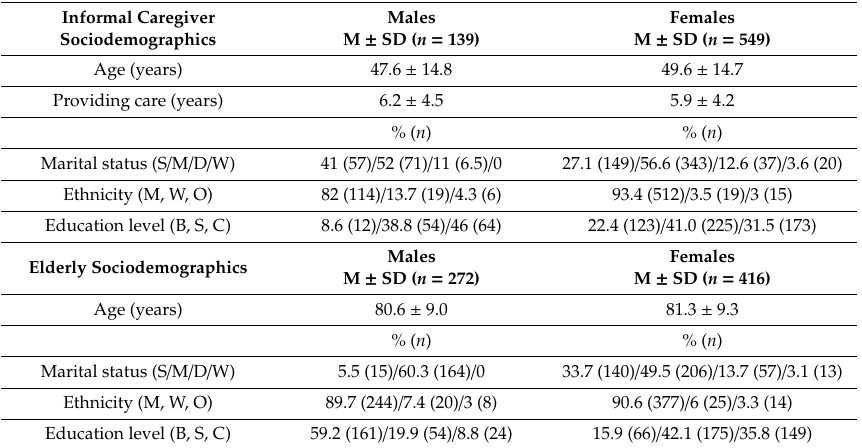
Table 1. Sociodemographic information of informal caregivers and elderly.